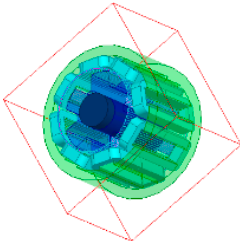
Figure 1. The structure of switched reluctance machine (SRM).